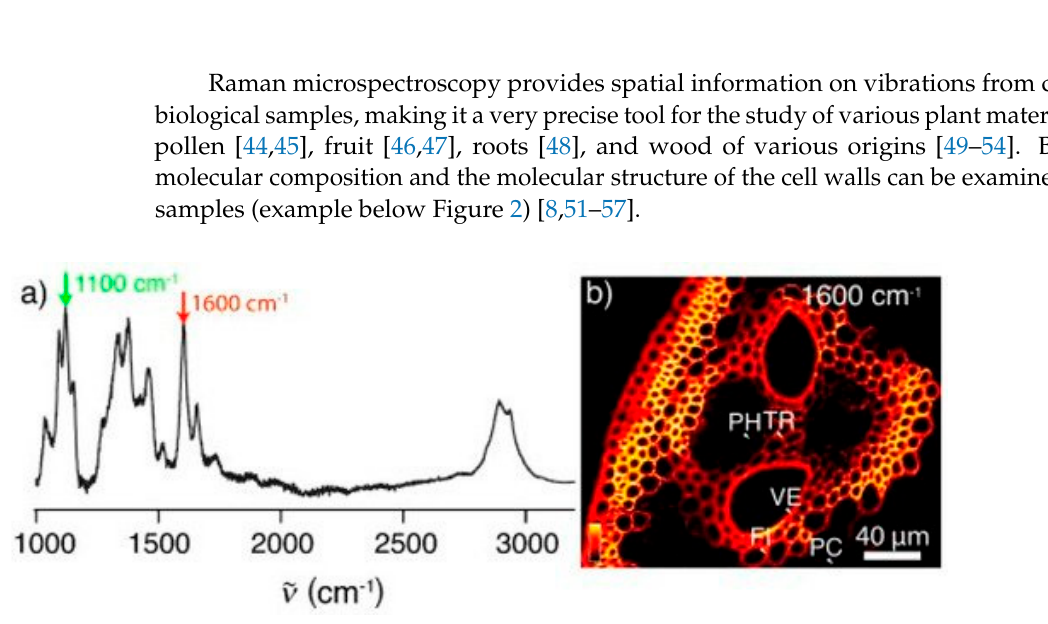
Figure 2. Raman spectrum of corn stover ( a ) and stimulated Raman scattering (SRS) microscopy imaging of corn stover at 1600 cm − 1 ( b ) illustrating the lignin distribution.